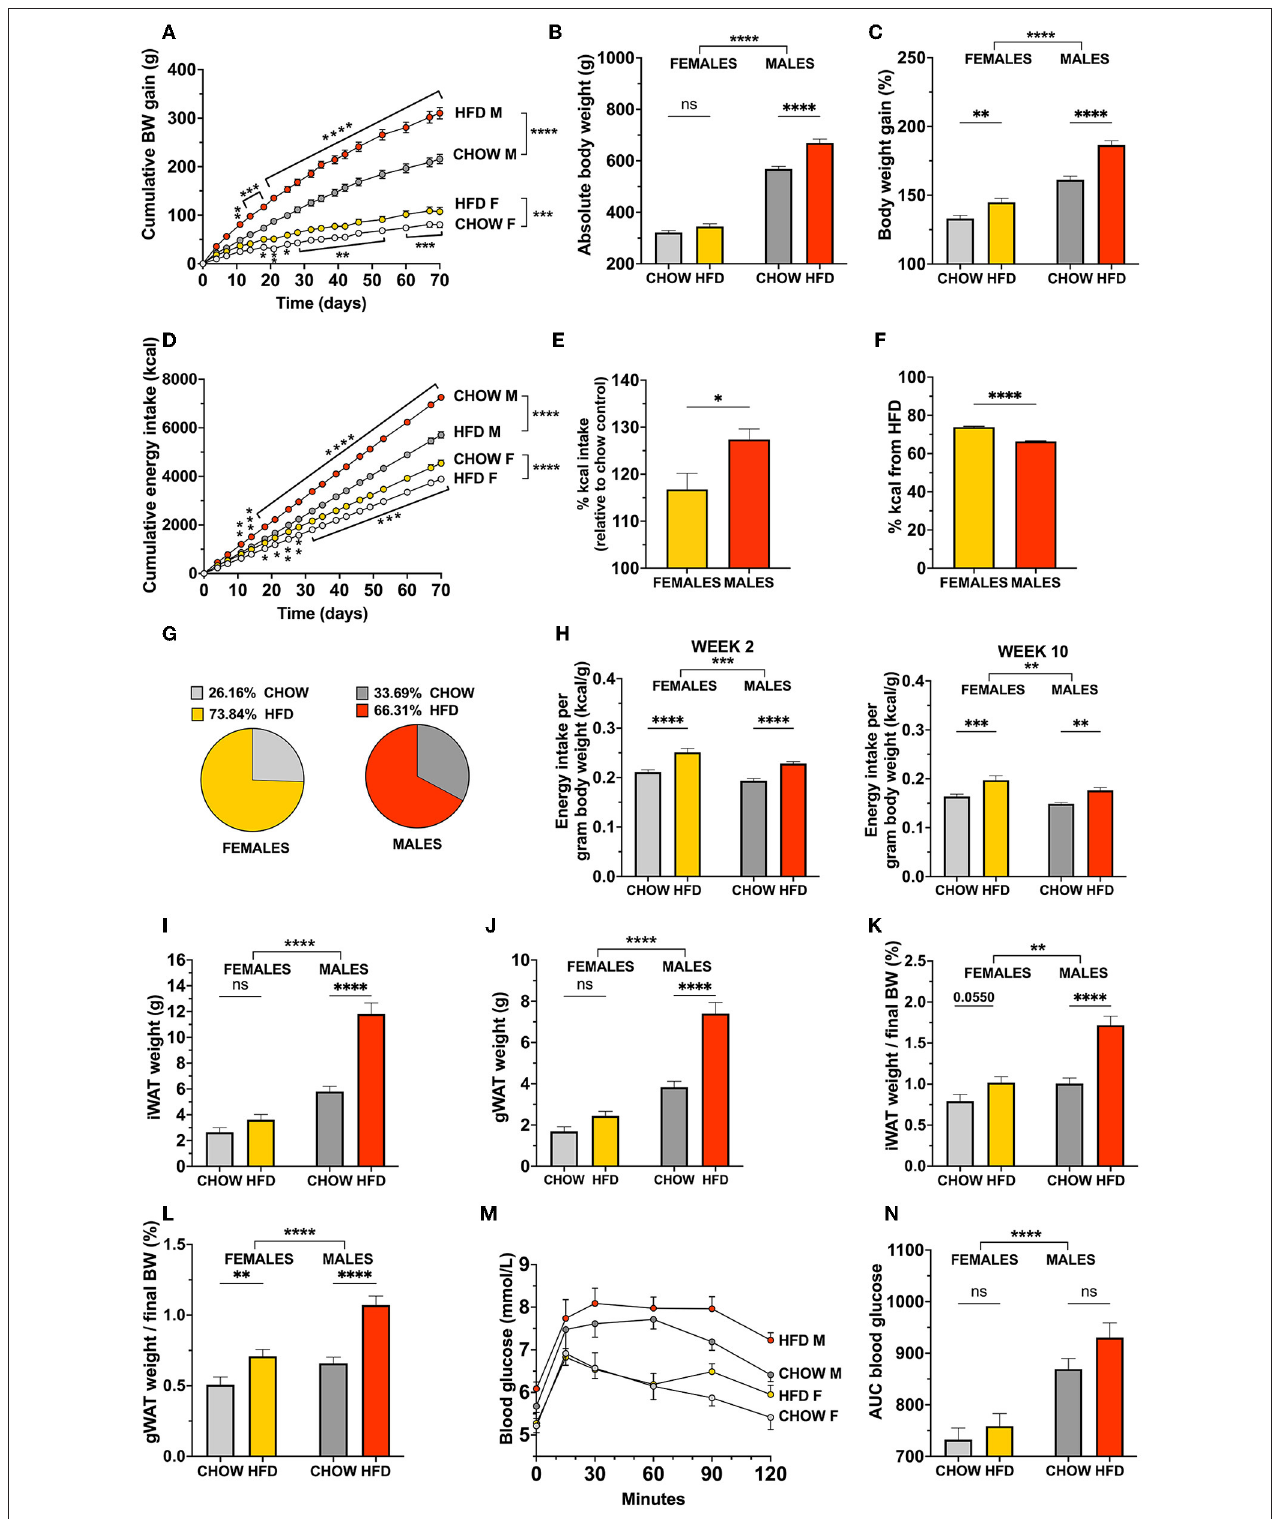
FIGURE 1 | Body weight and food intake control in response to a high-fat choice diet challenge is sex divergent in rats. Offering an obesogenic choice diet to both female and male rats increased cumulative body weight (A) and promoted hyperphagia (D) compared to their respective chow-fed controls. Females chose to consume a higher proportion of their daily intake from HFD (F,G) but males displayed a greater level of total overeating (E) . Both sexes consumed more calories